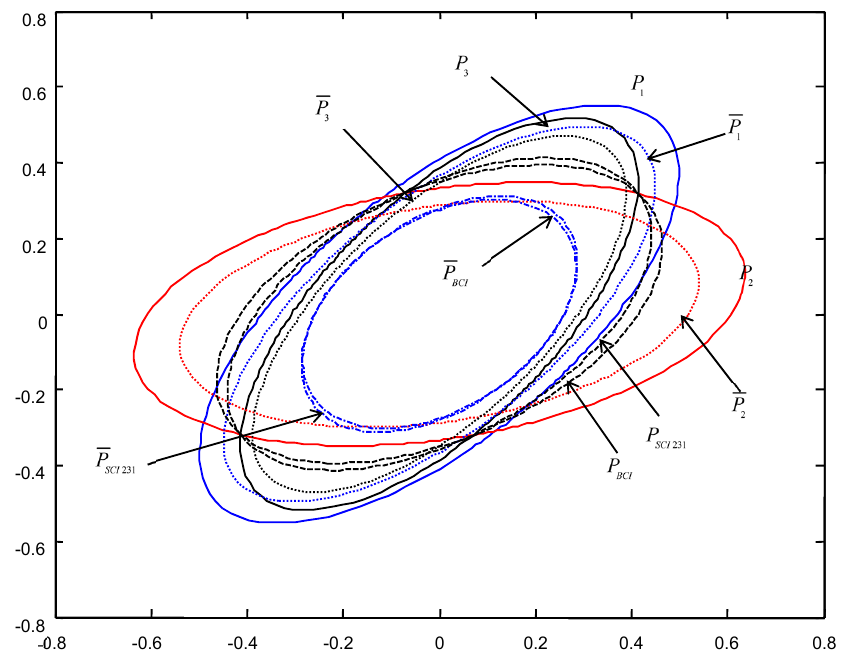
Figure 9. The ellipses of the actual and conservative steady-state filtering error variances of the order 231 SCI .